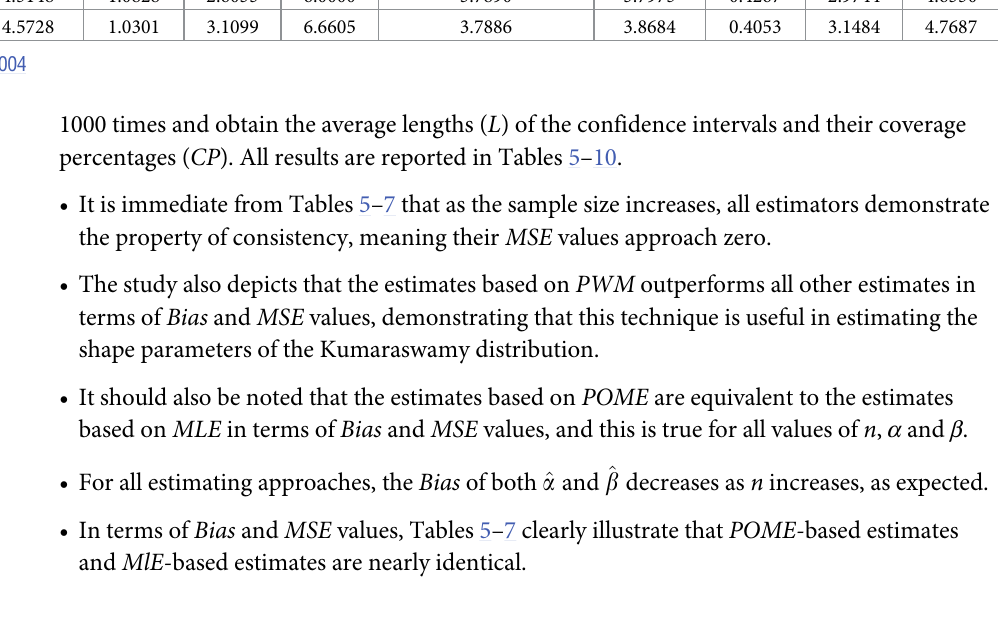
Table 5. Bias and MSE (parentheses) for the estimators of α and β when α = β and for different choices of n